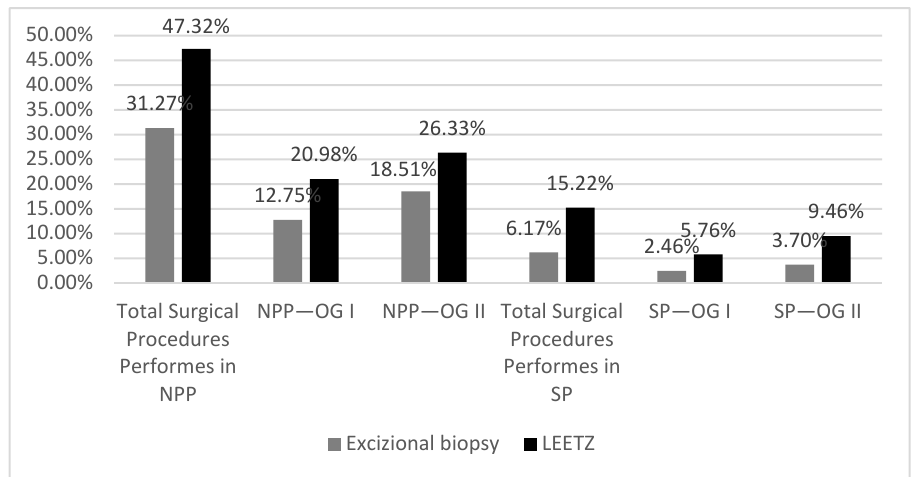
Figure 5. Surgical procedures performed in both clinics of the Emergency County Hospital in the year before the pandemic and the first year of the SARS-CoV-2 pandemic. OG: Obstetrics and Gynecology Clinic. NPP: non-pandemic period; SP: first year of SARS-CoV-2 pandemic; LEETZ: Large loop excision of the transformation